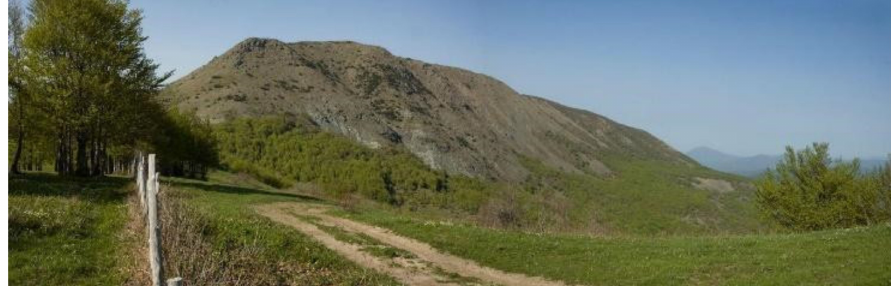
Figure 2. Panoramic view of Mt. Ragola massif (1712 m a.s.l.) from the west